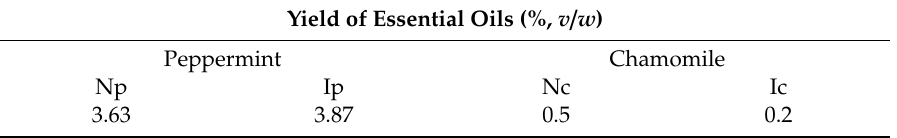
Table 2. Yields of essential oils obtained from peppermint and